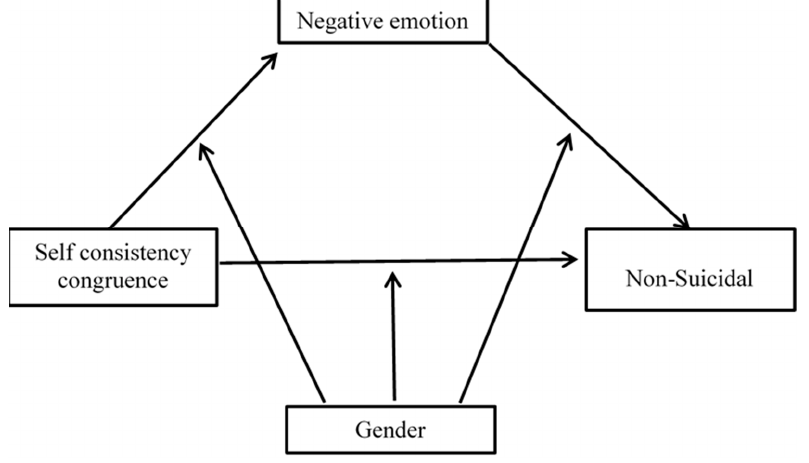
Figure 1. Moderated mediation model.